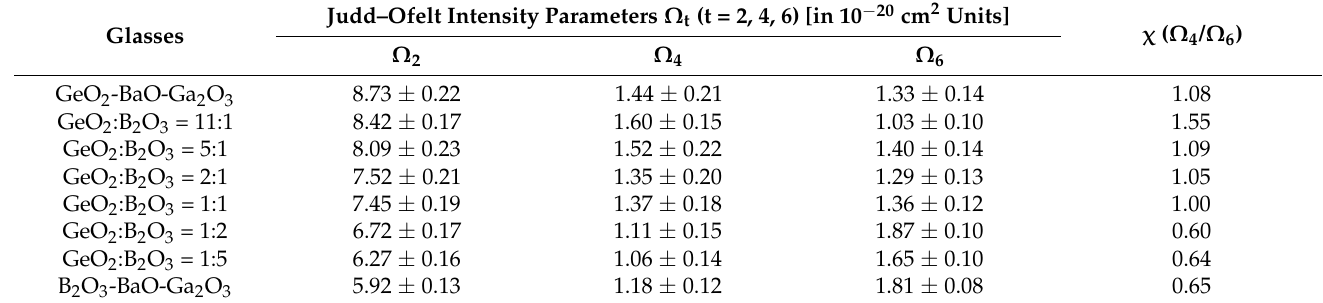
Table 5. Judd–Ofelt intensity parameters for Dy 3+ ions in the studied glass